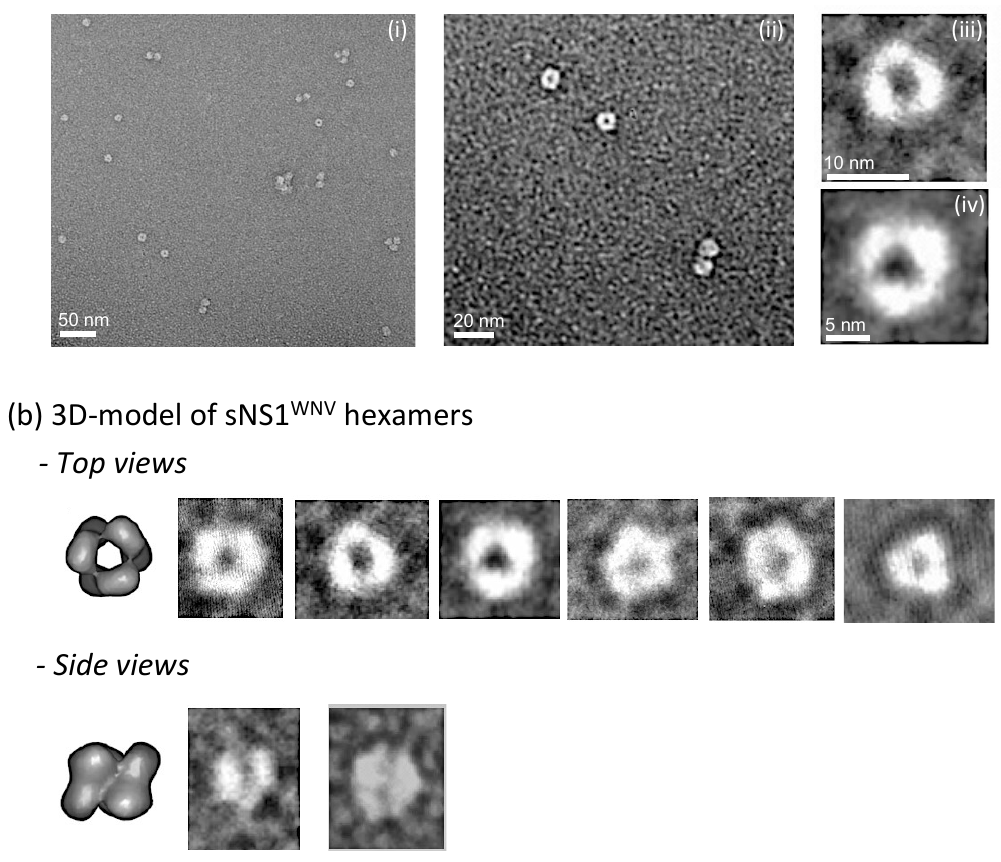
Figure 2. Electron microscopy control of extracellular sNS1 WNV . Samples from the extracellular medium of pNS1 WNV-IS98 -transfected HEK-293T cells were purified by a ffi nity chromatography on a Ni 2 + -agarose column, and the oligomeric status of sNS1 WNV proteins was verified by electron microscopy (EM). ( a ) EM images of negatively stained samples observed at low ( i ) and high ( ii ) magnifications. ( iii , iv ) Enlargements of individual sNS1 WNV hexamers. ( b ) Three-dimensional model previously proposed for NS1 DENV [4], and comparison with enlargements of sNS1 WNV hexamers presented from di ff erent incidences—top and side